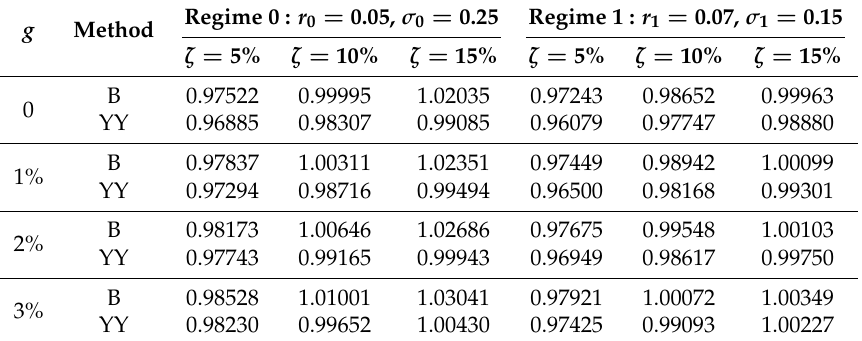
Table 5. Equity-indexed annuity fair values in a two-regime economy with a 0,1 = a 1,0 = 1 (1/year).